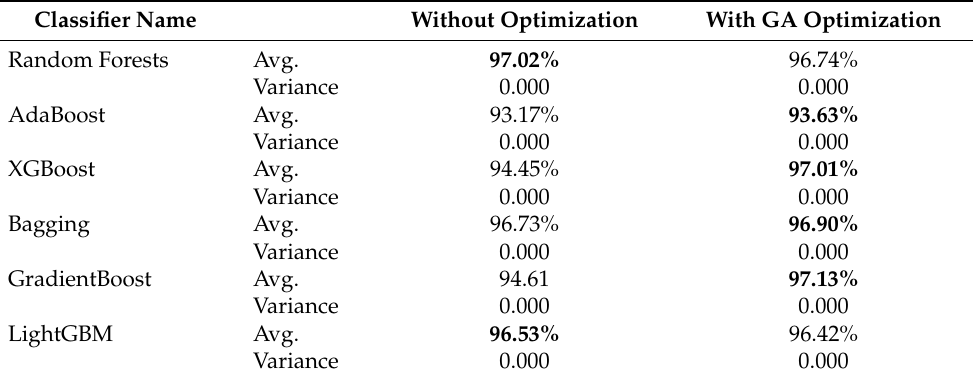
Table 13. The average accuracy and variance values of all of the classifiers, before and after conducting GA optimization.